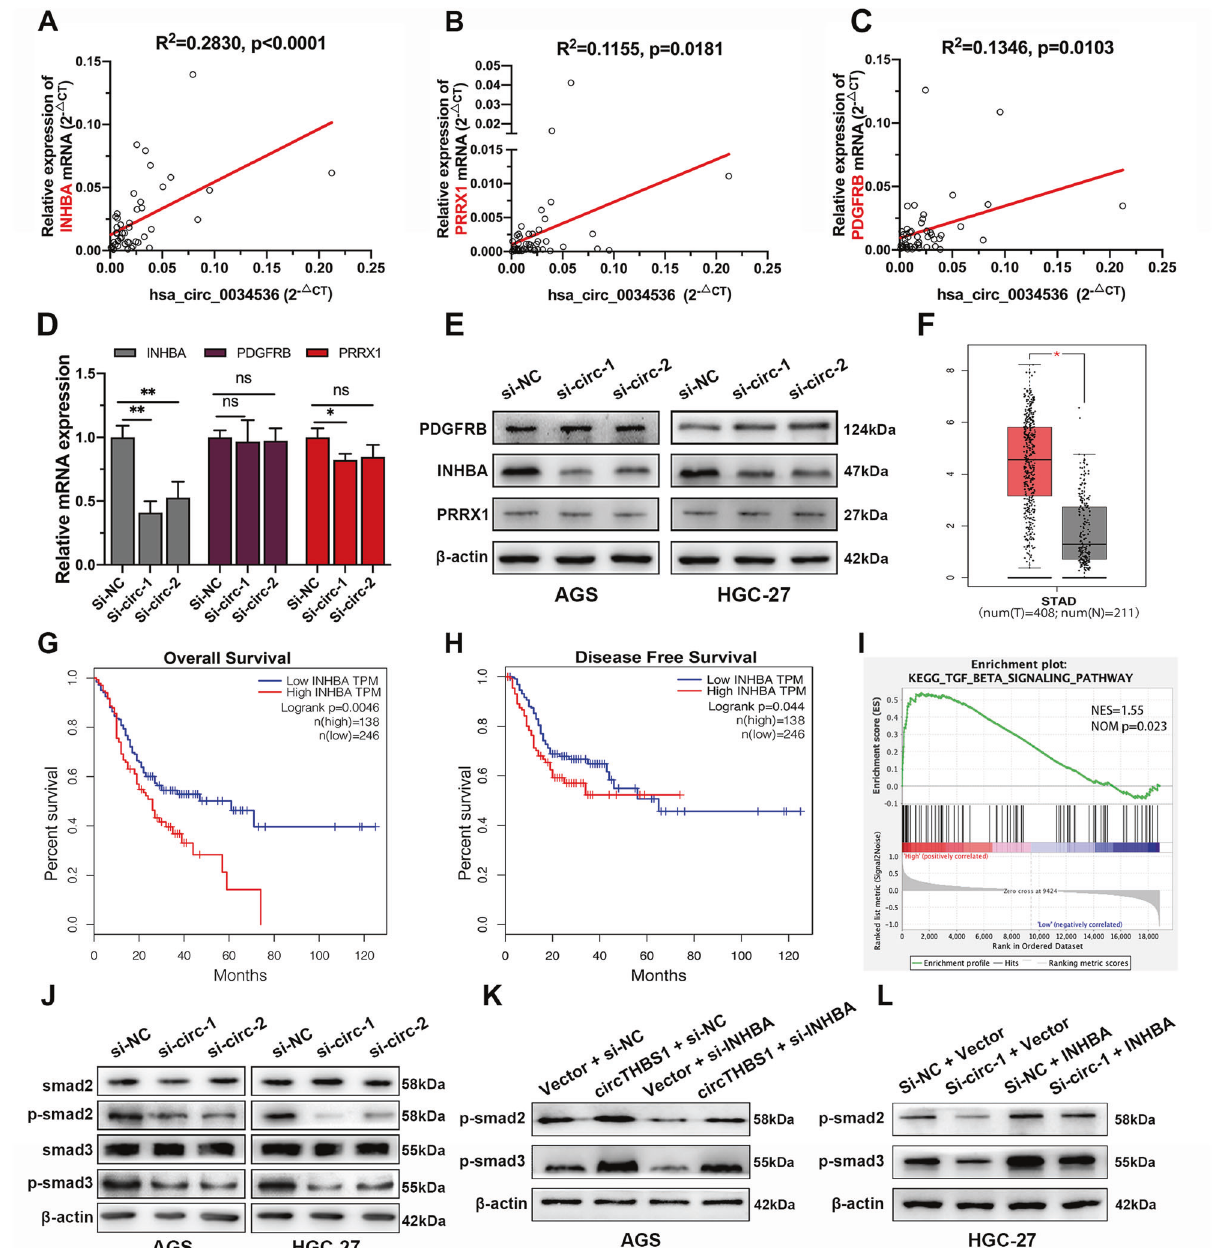
Fig. 3 circTHBS1 activates TGF- β signaling pathway via upregulation of INHBA. A – C The correlation of circTHBS1 with its downstream target genes were veri fi ed by qRT-PCR in 48 GC tissues. These three genes were the most strongly correlated with circTHBS1 expression after SOM analysis. D Expression of INHBA, PDGFRB, and PRRX1 in HGC-27 with knockdown of circTHBS1 were detected by qRT-PCR. E Western blot of INHBA, PDGFRB, and PRRX1 in GC cells transfected with si-circTHBS1. β -actin was used as an internal control. F The expression of INHBA in GC tissues and normal tissues (from the TCGA database). G, H The overall survival and disease-free survival of GC patients based on INHBA expression in TCGA database. I Gene enrichment analysis (GSEA) based on the results of our ceRNA array. Brie fl y, the expression of circTHBS1 from ceRNA arrays was used as a phenotypic label and the data of all the mRNAs was de fi ned as gene set. J Western blot of key proteins involved in TGF- β pathway in AGS and HGC-27 cells with knockdown of circTHBS1. K Western blot assay showed that knockdown of INHBA in AGS cells impaired the activation of TGF- β pathway by overexpression of circTHBS1. L Overexpression of INHBA in HGC-27 cells rescued the inhibitory effect of Knockdown circTHBS1 on TGF- β pathway. Quantitative data presented as the mean ± SD. * P < 0.05, ** P < 0.01, *** P < 0.001 (Student ’ s t